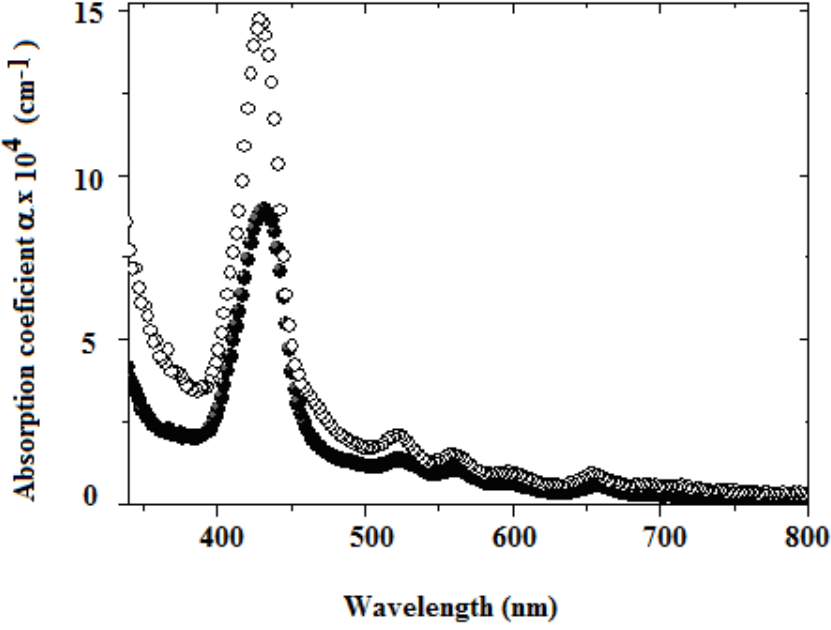
Figure 3. Optical linear absorption coefficient of polymer films doped ferrocene and porphyrin-containing dendrimers 12 (filled circles) and 13 (open